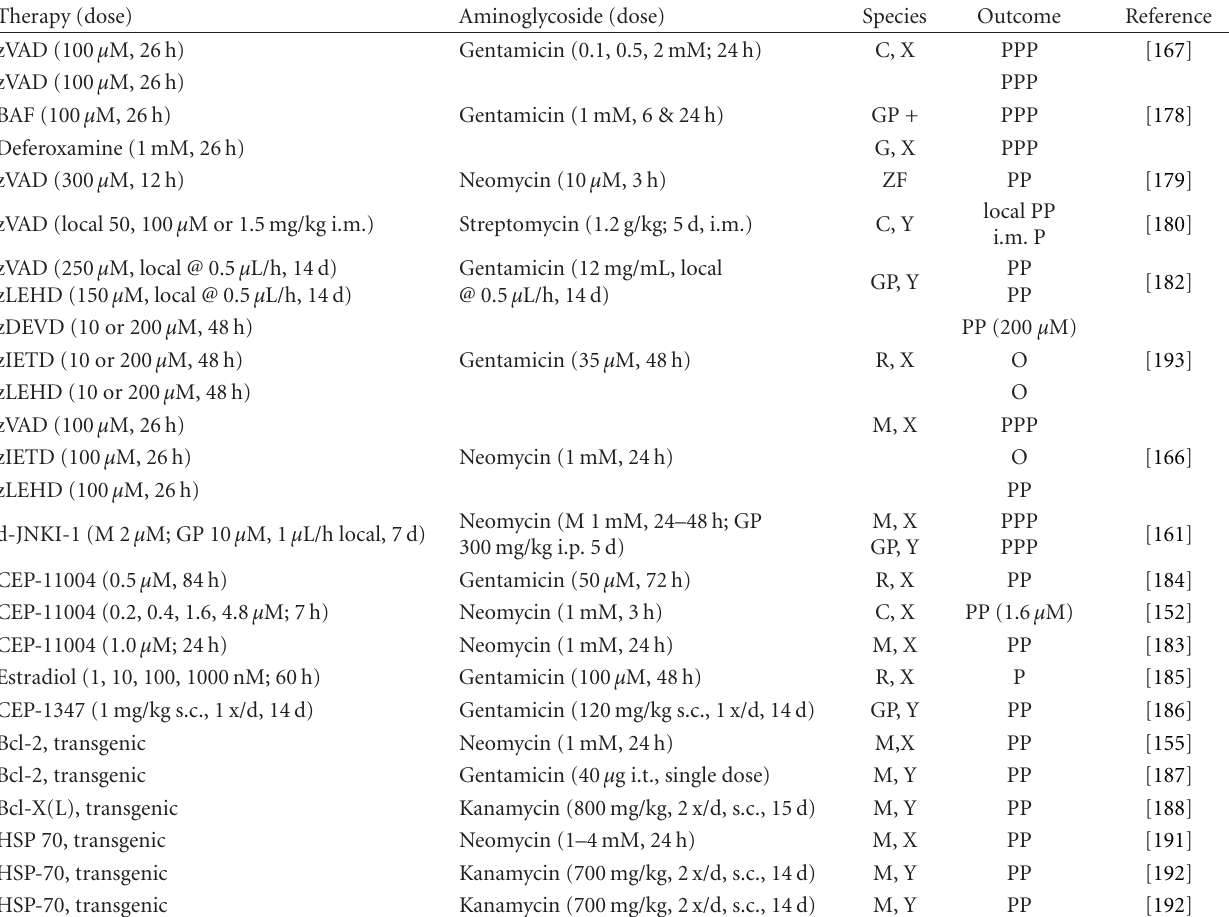
Table 1: Overview of studies performed to protect from aminoglycoside ototoxicity by inhibition of apoptosis. C: Chicken, G: Gerbil, GP: Guinea Pig, M: Mouse, R: Rat, ZF: Zebrafish; X: in vitro , Y: in vivo ; i.m.: intramuscular, i.p.: intraperitoneal, i.t.: intratympanic, s.c.: subcutaneous; d: day, h: hour; O: no e ff ect, P/PP/PPP: partial, not significant/partial and statistically significant/complete and